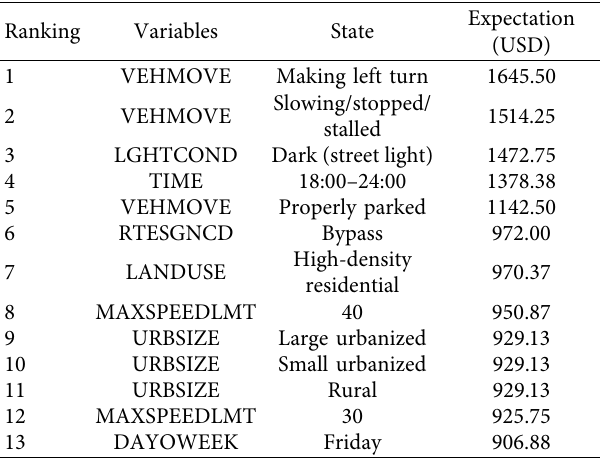
Table 4: Expectation of property damage in parking lot accidents (more than